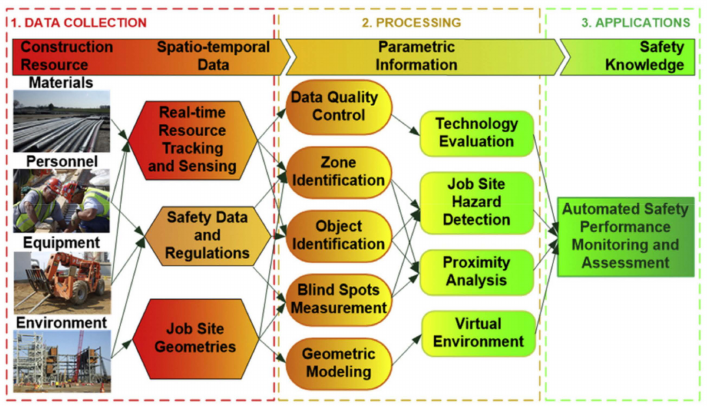
Figure 6. Data collection, information processing, and application framework of RTLS [52].